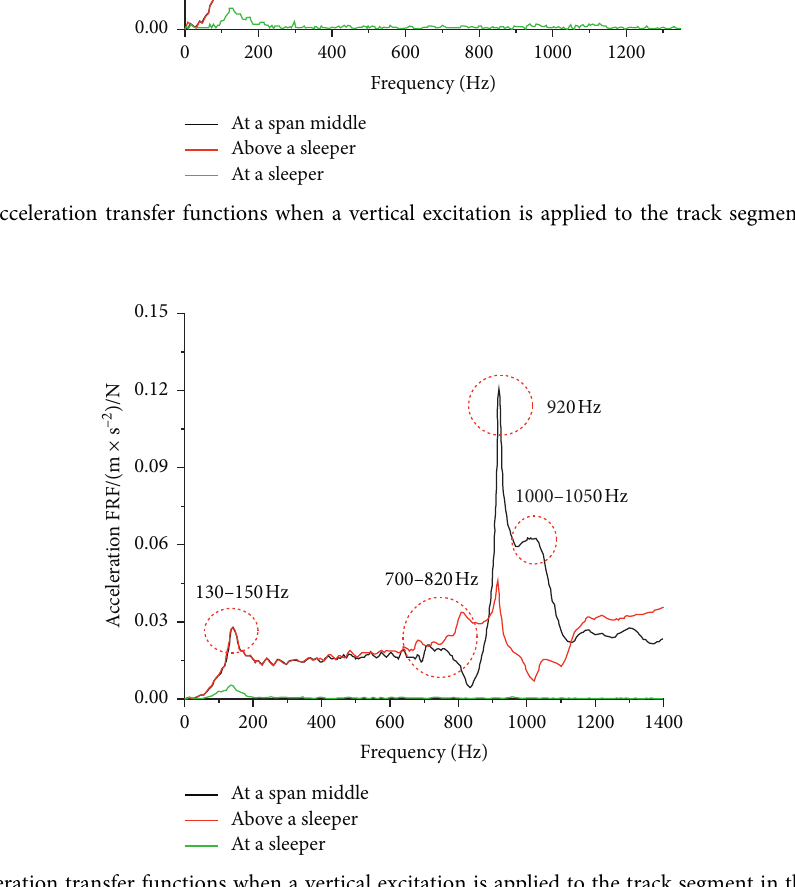
Figure 19: Vertical acceleration transfer functions when a vertical excitation is applied to the track segment in the middle of the sleeper